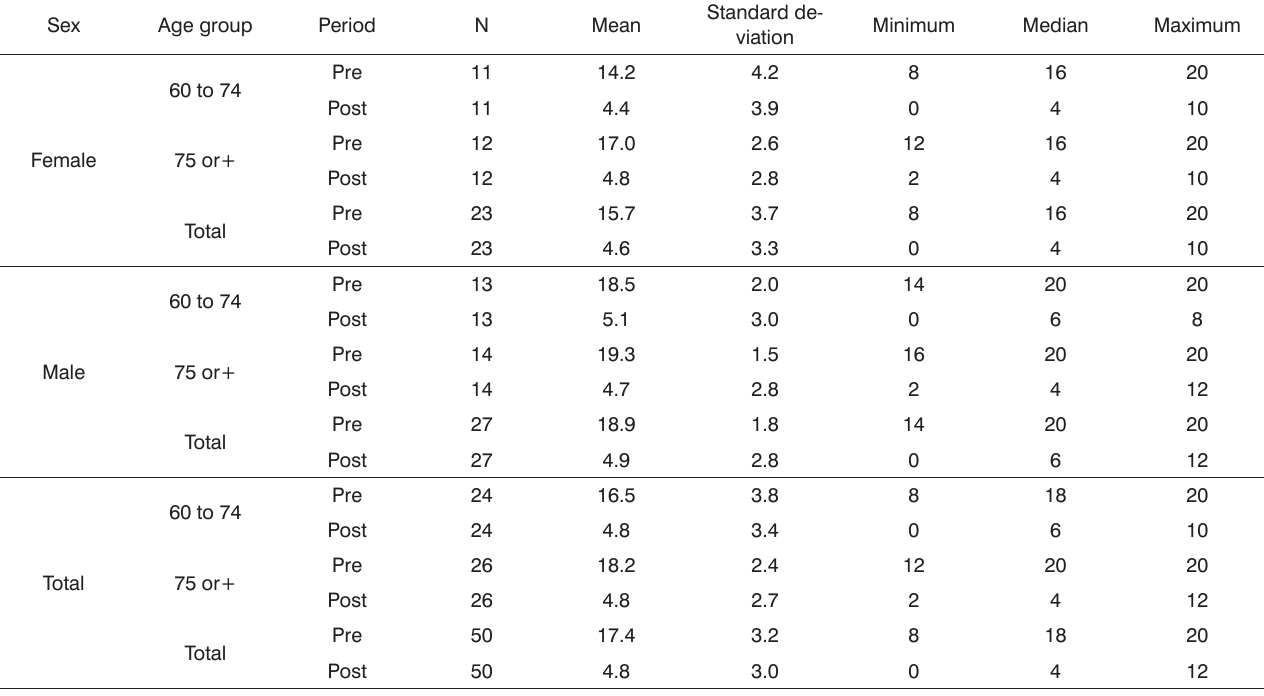
Analysis of variance Pre x Post x Sex → p = 0.004*